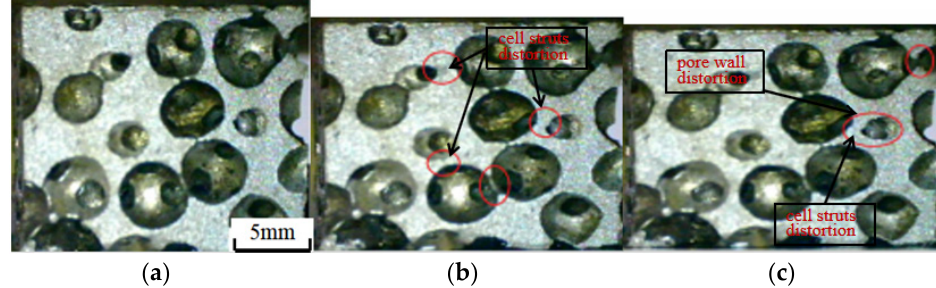
Figure 13. Surface images of the specimen during fatigue test (k = 1.0): ( a ) 0 strain; ( b ) 5% strain; ( c ) 10% strain.